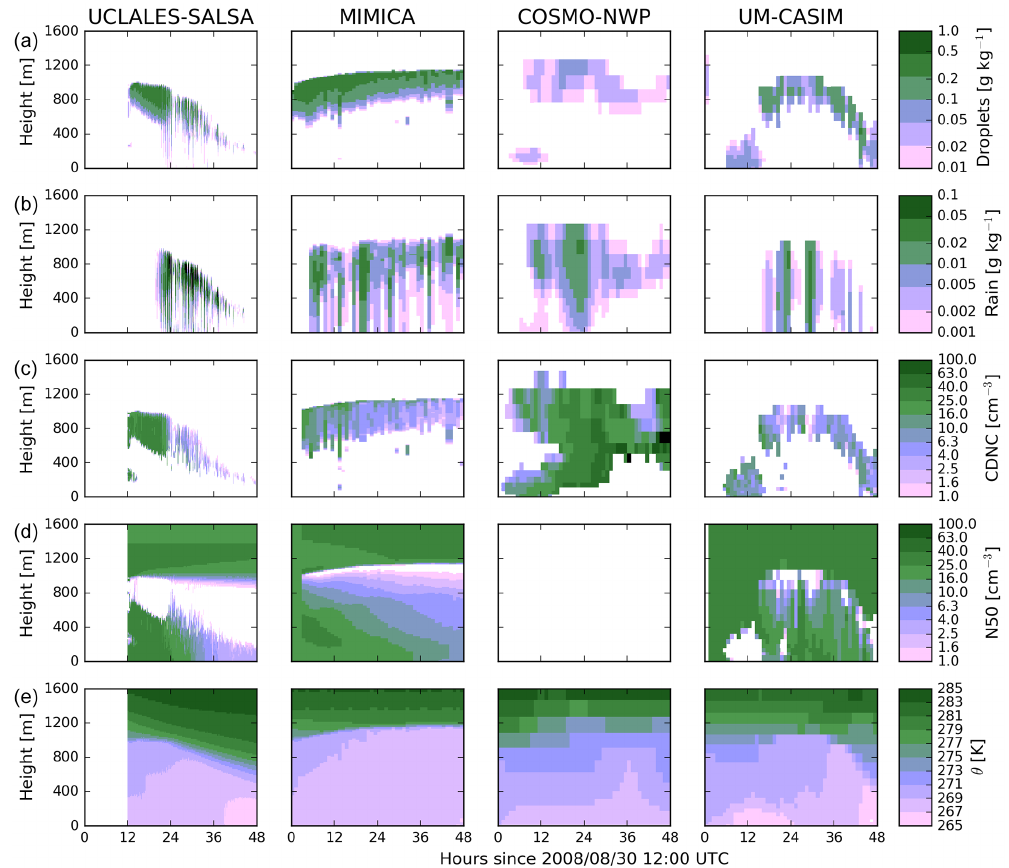
Figure 9. Cloud properties in the simulations with prognostic aerosol and an initial CCN concentration of 30cm − 3 (CCN30prog_NOICE). (a) Cloud droplet mass mixing ratio, (b) rain mass mixing ratio, (c) cloud droplet number concentration, (d) N50 concentration, and (e) po- tential temperature. Results are shown (from left to right) from the UCLALES-SALSA, MIMICA, COSMO-NWP, and UM-CASIM models. Note that aerosol concentrations and CDNCs are fixed during the 2h spin-up period in MIMICA, and N50 concentrations are not available for